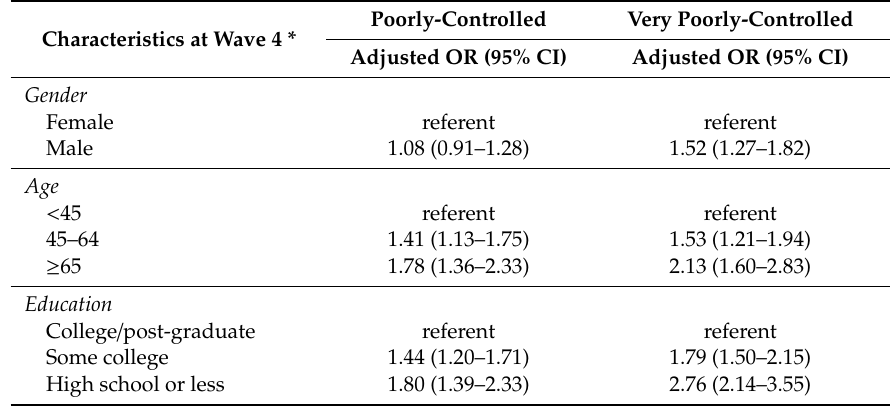
Table 2. Multivariable odds ratios for association of level of asthma control with air pollution / irritants, controlling for selected sociodemographic factors, WTC dust cloud exposure, physical and mental health co-morbidities among 9 / 11-exposed individuals with asthma,